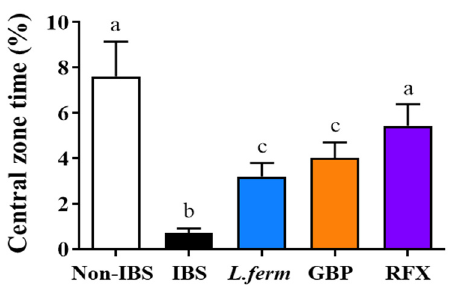
Figure 1. Time spent in central zones of the OF was quantified to assess anxiety-like behavior of DCA vehicle (Non-IBS), 4 mmol/L DCA (IBS), L. fermentum (10 9 CFU) ( L. ferm ), Gabapentin at 70 mg/kg (GBP) and Rifaximin at 150 mg/kg (RFX)-treated rats. Data are expressed as means (triplicate measurements) ± SEM ( n = 10). Groups with different letters are statistically different ( p < 0.05).